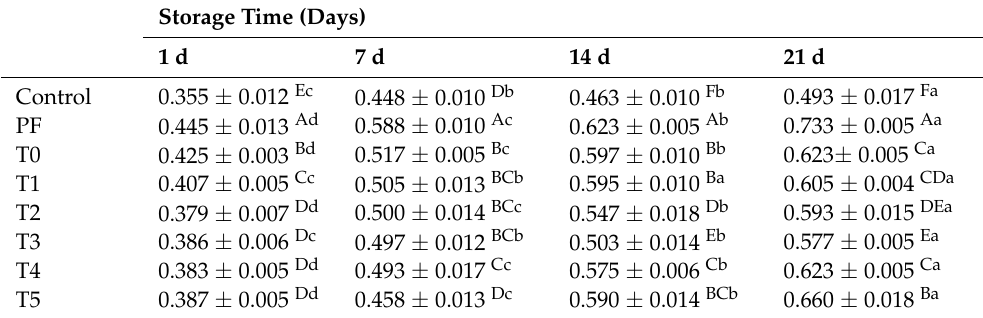
Table 8. The thiobarbituric acid reactive substances (TBARS) value (mg malonaldehyde/kg sample) of phosphate-containing frankfurters or phosphate-free frankfurters added with the combination of L-Arg and PC during 21 days of